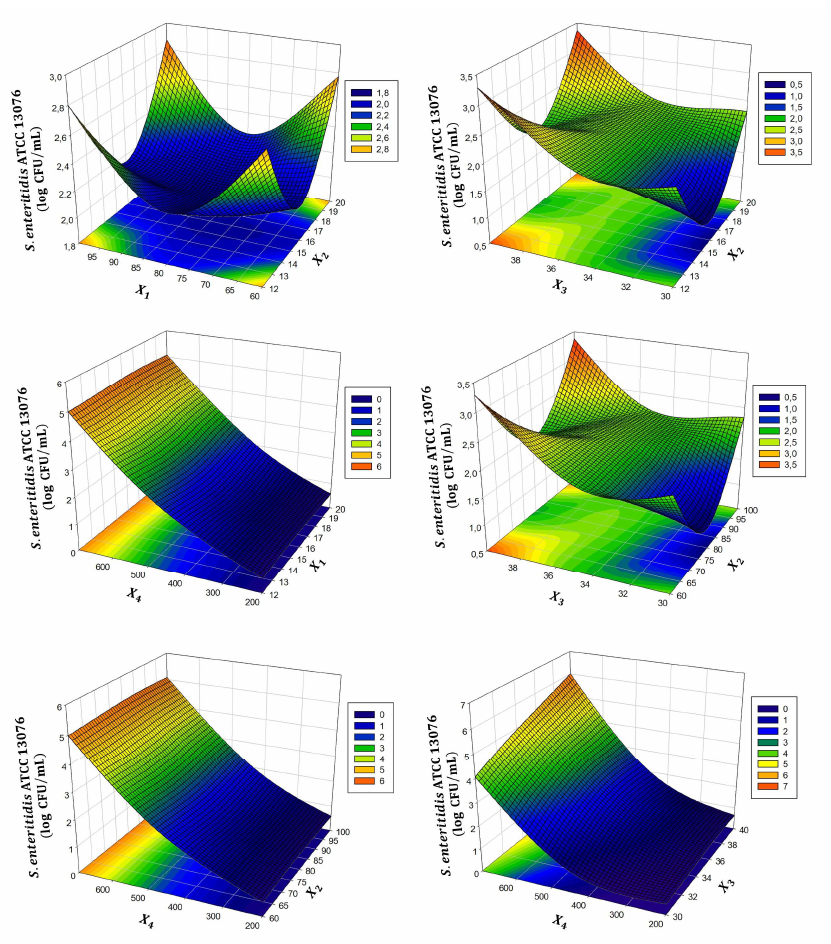
Figure 3. Three-dimensional response surface plots representing the effect of process variable on S . Enteritidis ATCC 13076: (X 1 ) ultrasound time (min); (X 2 ) ultrasound amplitude (%); (X 3 ) microwave time (s); (X 4 ) microwave power (W). Similar to this research, microwave heating at 220 to 660 W reduced Salmonella spp. numbers in tahini by 0.5 to 4.8 log 10 CFU/g, with a range from 6.18 to 0.50 min D-values [51]. Huang et al. (2006) reported that high pressure processing and ultrasound treatments could achieving of 3.2 log cycles reduction for S . Enteritidis. [52]. Xiufang et al. (2020) found that ultrasound caused a reduction in 3.31 log cycles in S . Typhimurium at 968 W/cm 2 and 35 °C for 20 min in liquid whole egg [53]. Ferrario and Guerrero (2016) reported a 6.3 log CFU reduction in S . Enteritidis in ultrasound (600 W, 20 kHz) and pulsed-light (3800 V, 1.27 J/cm 2 )-treated apple juice [54]. As shown below, a quadratic polynomial regression equation (8) was created by RSM to evaluate the relationship between the ultrasound–microwave treatment parameters and L. monocytogenes inhibition, as shown in Table 2.